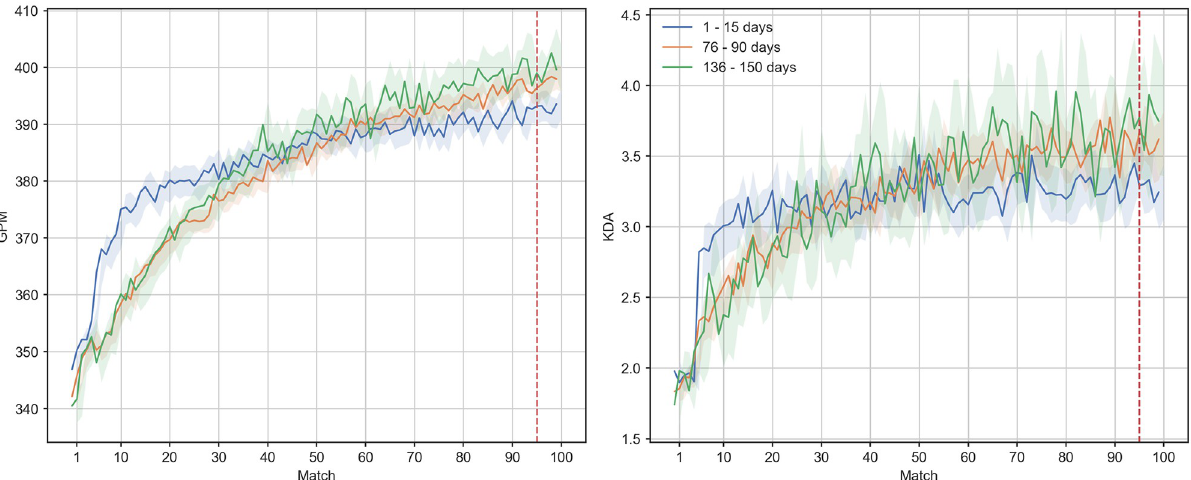
Fig 2. Trajectories of mean GPM (left panel) and KDA (right panel) against match for players with different patterns of match spacing. Data in the figure are a subsample of players who initiate at a similar range of GPM and KDA (approximately surrounding the original sample median). Shaded regions indicate 95% confidence